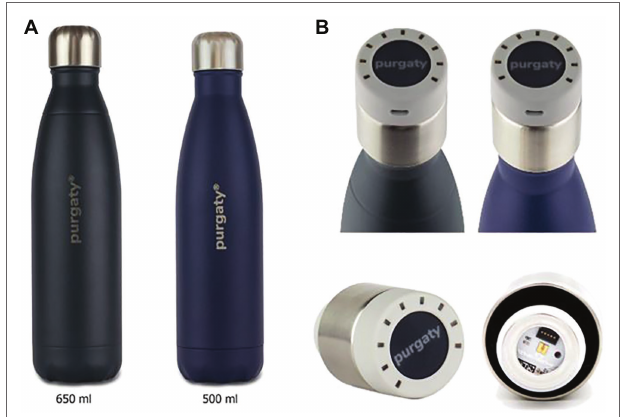
FIGURE 1 | (A) Test bottles whose ordinary caps can be replaced with UV subtype C (UVC) emitting purgaty brain (B) The UVC emitting purgaty brain threaded onto both bottles (top) and shown individually from a side view and from the bottom